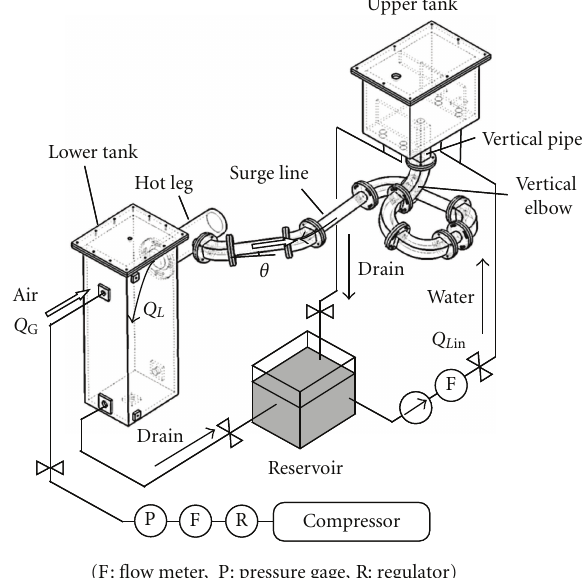
Figure 1: Experimental setup (Surge line).